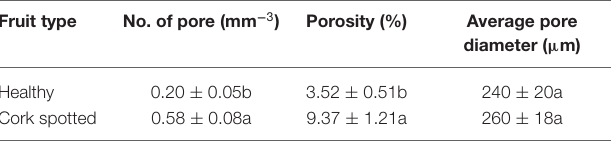
TABLE 3 | Microstructure analysis of healthy and cork spotted “Akizuki” fruit using the segmentation of the X-ray scanning data of the whole fruit. Fruit